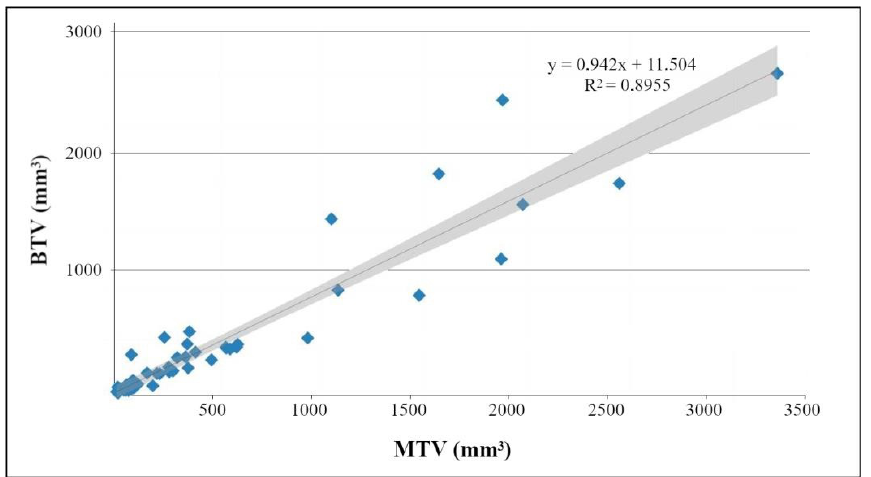
Figure 5. Correlation of manually measured tumor volumes (MTV) and the tumor volumes obtained from the PET scans (BTV). The gray area marks the confidence band of the linear regression.